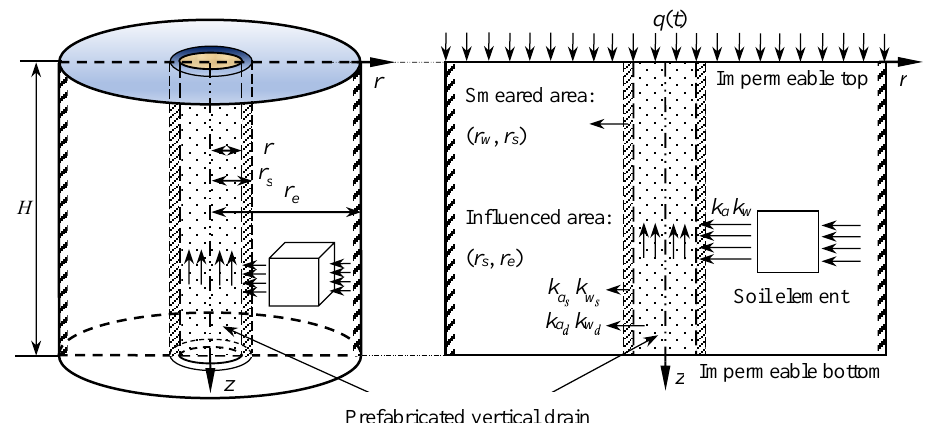
Figure 1. Consolidation modeling of unsaturated PVD foundation under time-dependent loading.